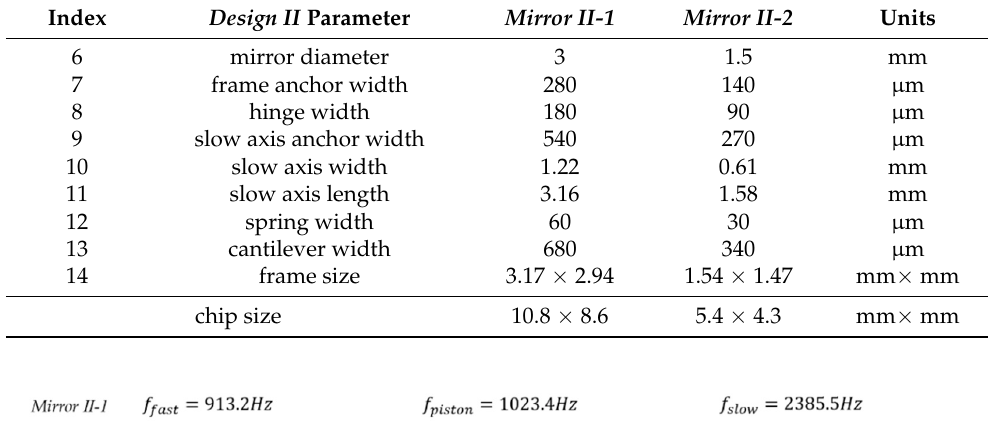
Table 2. The main parameters of Mirror II-1 and Mirror II-2.